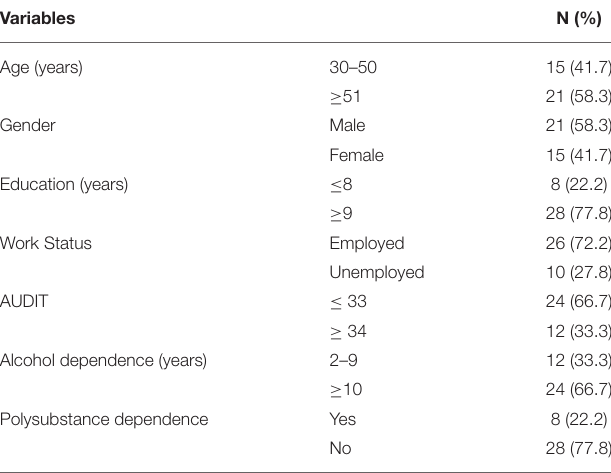
TABLE 1 | Sociodemographic and clinical characteristics of the sample ( N =